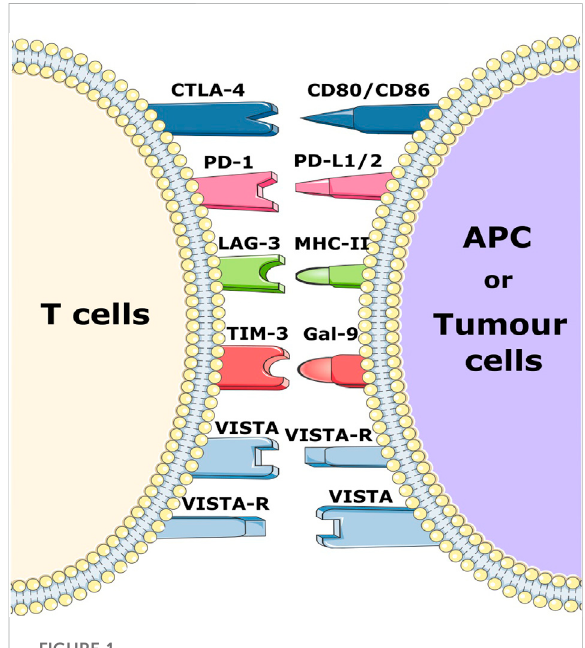
FIGURE 1 Schematic representation of various immune checkpoint receptors and their respective ligands. Immune checkpoint molecules expressed on T cells bind to their respective ligands on APCs and/or tumor cells and trigger a negative or positive signal to T